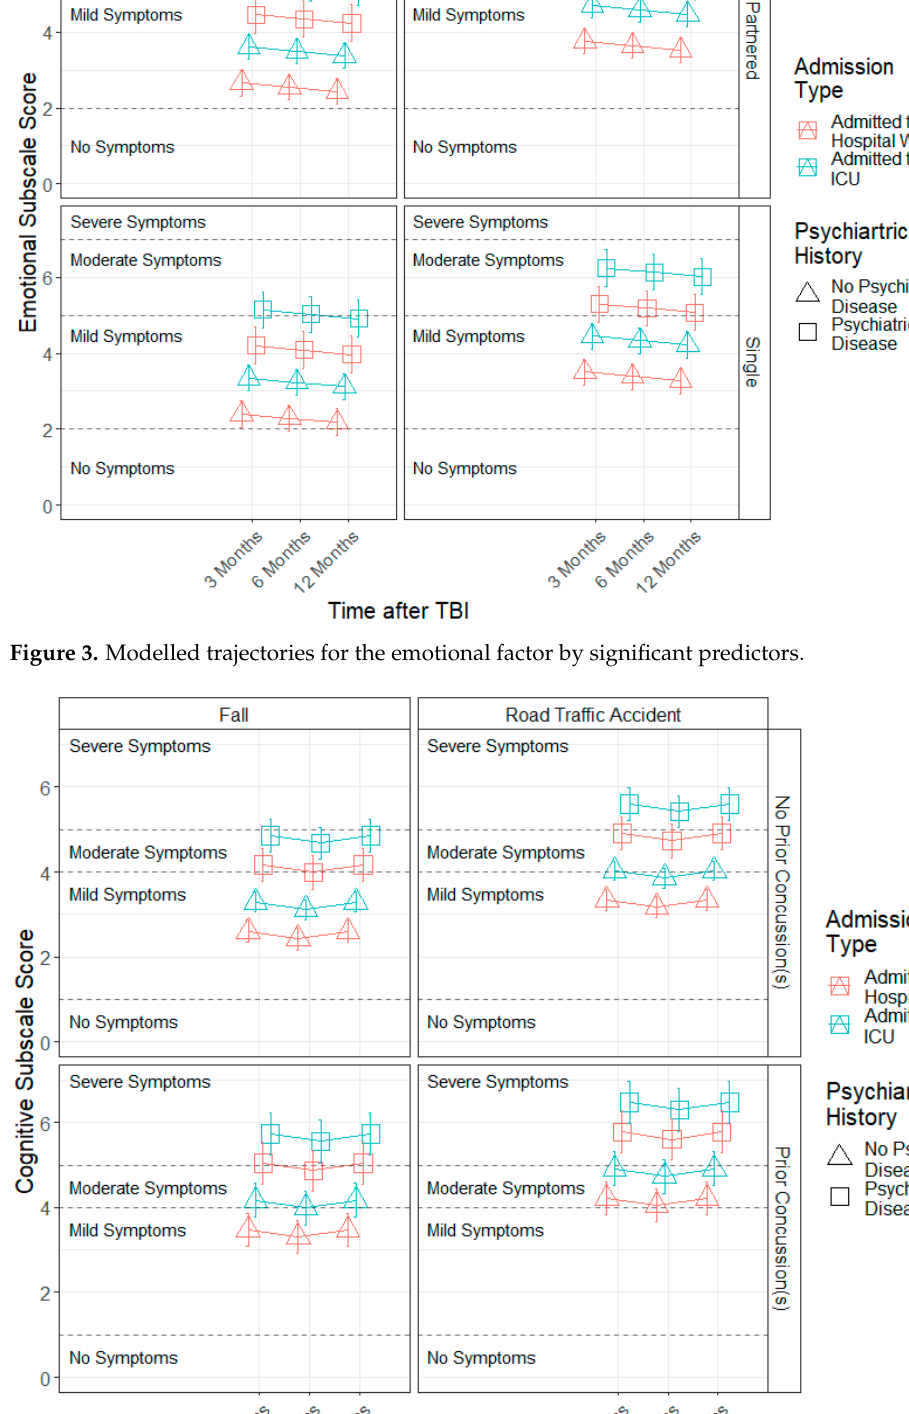
Figure 4. Modelled trajectories for the cognitive factor by significant predictors.